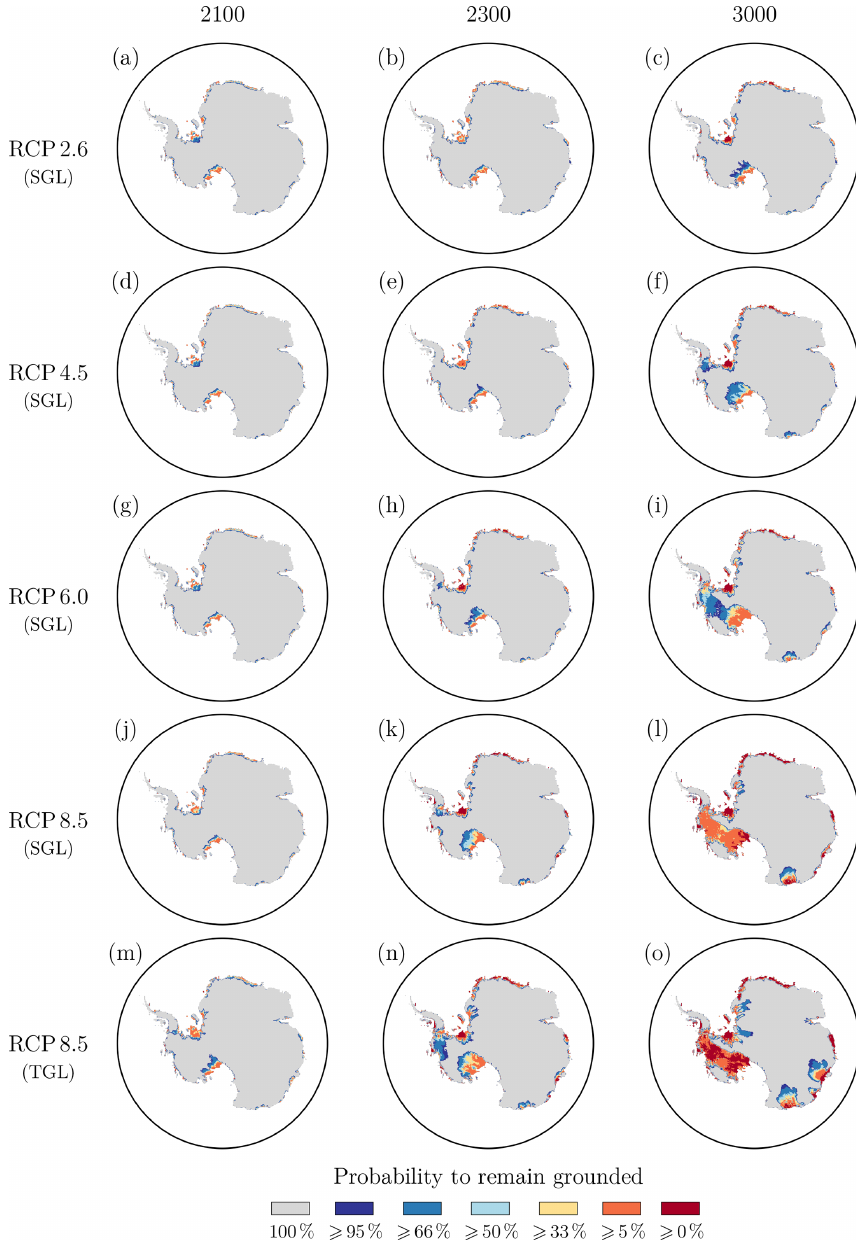
Figure 10. Confidence regions for grounded ice under the weakly non-linear sliding law. Confidence regions are shown at (a, d, g, j, m) 2100, (b, e, h, k,n) 2300 and (c, f, i, l,o) 3000. Results under (a–l) the SGL parameterisation and (m–o) the TGL